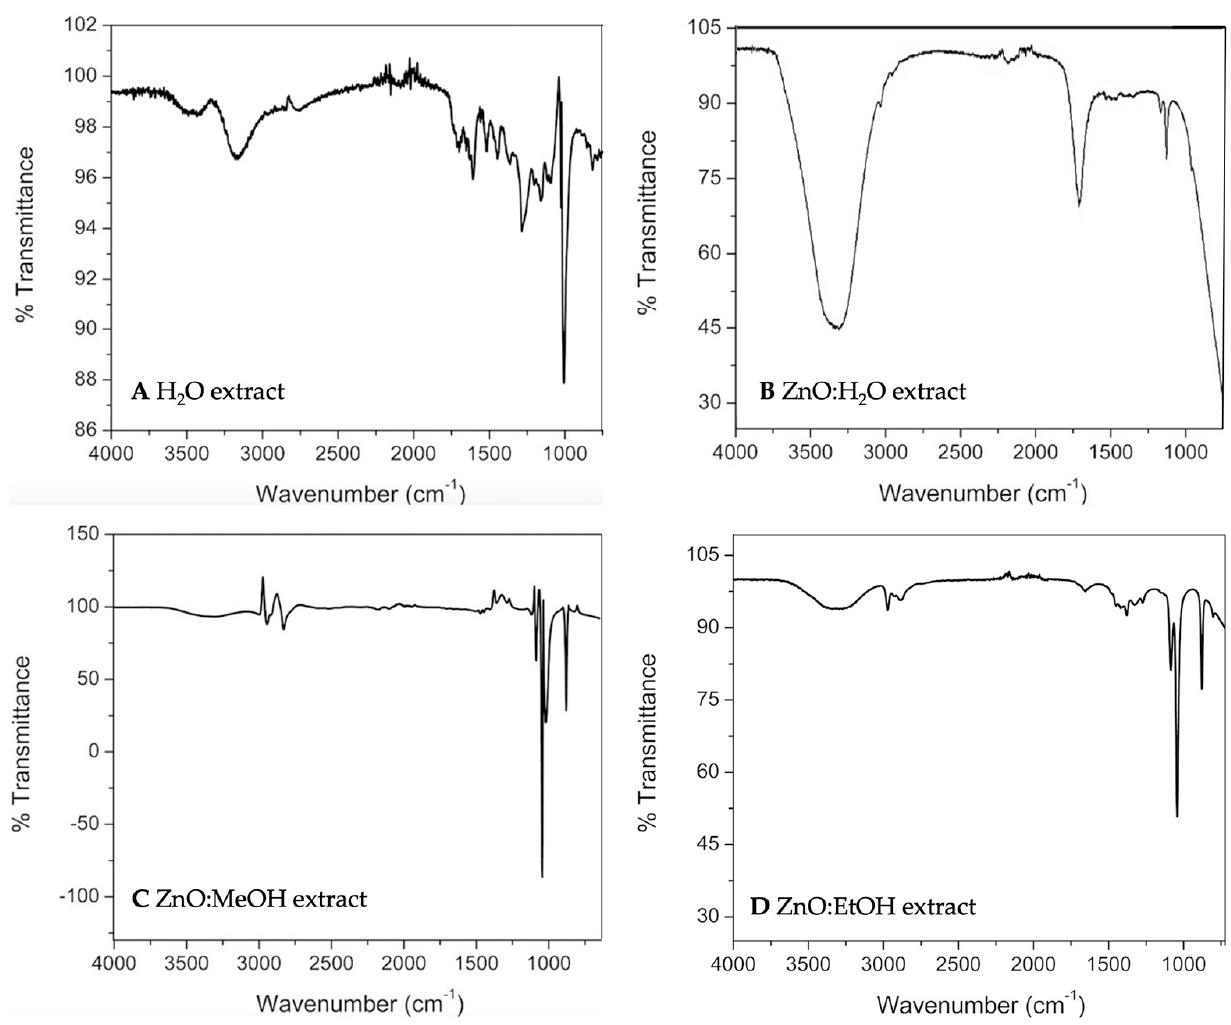
Figure 3. FTIR spectra for the water extract of coffee ( Coffea arabica L.) husks ( A ). A characteristic signal for cyanidin 3-rutinoside appears at 1000 cm − 1 . ZnO nanoparticle–anthocyanin conjugates from water ( B ), MeOH ( C ), and EtOH extraction ( D ). The presence of the cyanidin 3-rutinoside’s signal is still present after the immobilization in all of the cases.